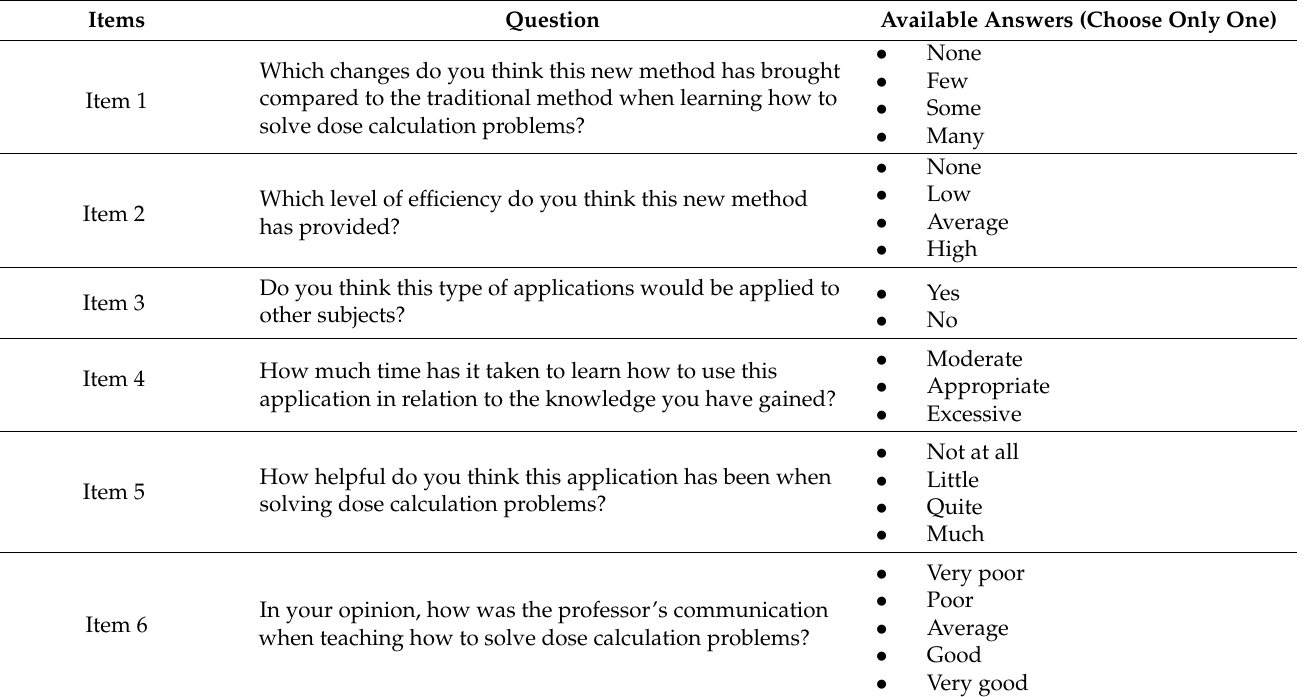
Table 2. Items in the final survey. Source: Prepared by